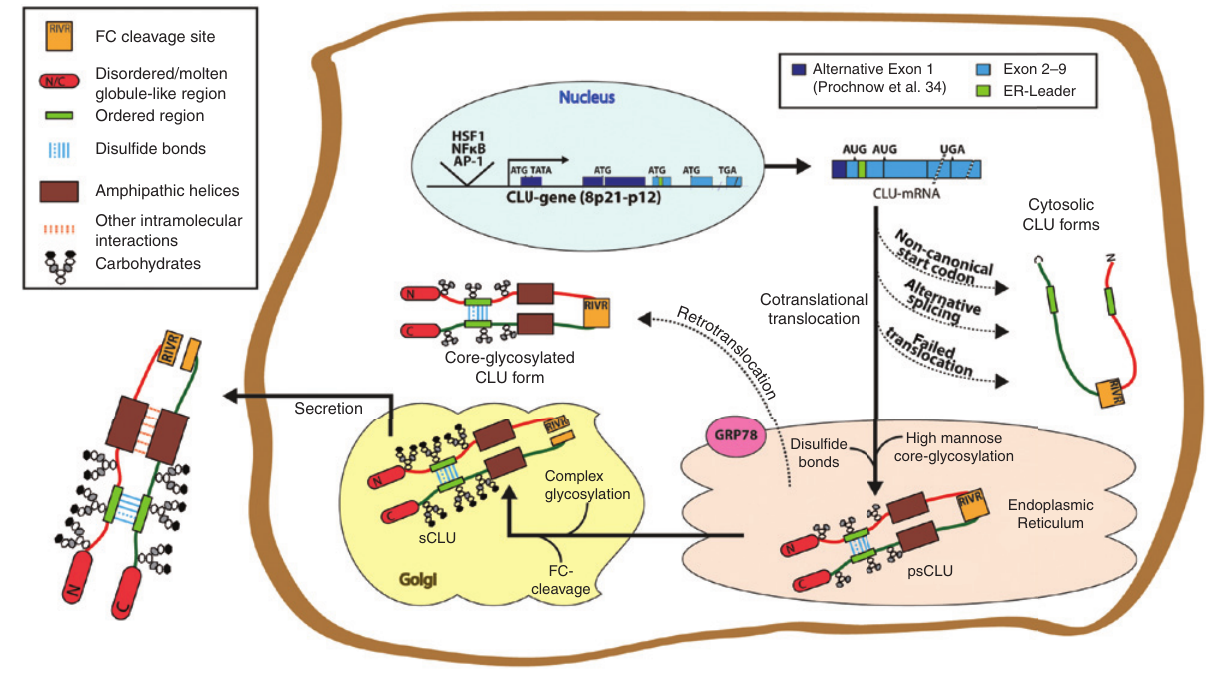
Figure 1: Illustration of CLU biosynthesis. The canonical pathway of secretory proteins leads to the synthesis of secretory CLU (sCLU). It undergoes proteolytic maturation and carries complex carbohydrate moieties as well as disulfide bonds. Upon cellular stress, non-canonic CLU forms emerge, mainly derived from failed translocation, alternative splicing or translation-initiation events on exon 3, as well as from retrotranslocation. All non-secreted CLU forms are incompletely maturated. For details please see